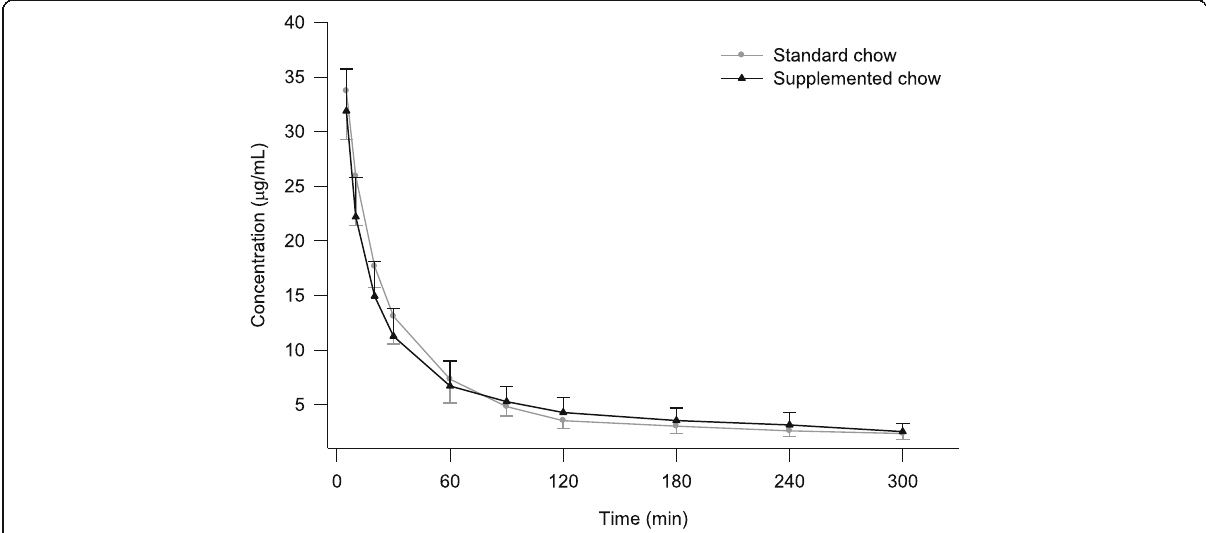
Fig. 1 Mean plasma concentrations of metformin in diabetic rabbits after the intravenous administration of 30